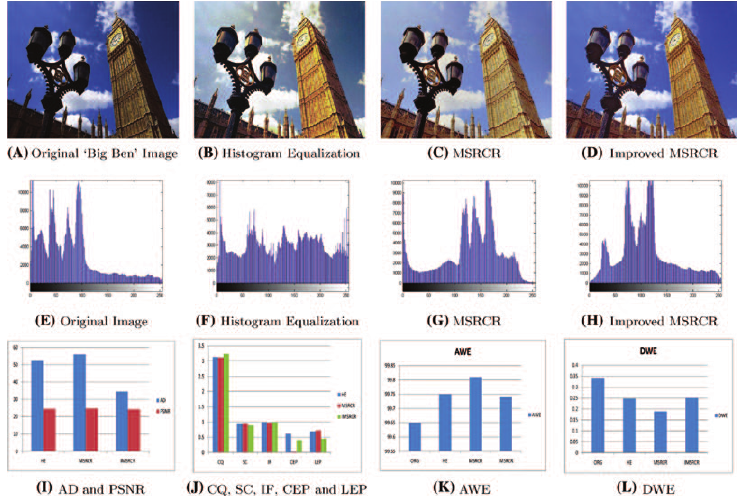
Figure 4. (Top) Image Enhancement Methods. (Middle) Histogram Plots: x -axis, Intensity Levels Ranging from 0 to 255; y -axis, Total Number of Pixels. (Bottom) Conventional Metrics and Proposed AWE and DWE Metrics. The “Big Ben” Image has been Downloaded from http://visl.technion.ac.il/1999/99-07/www/.